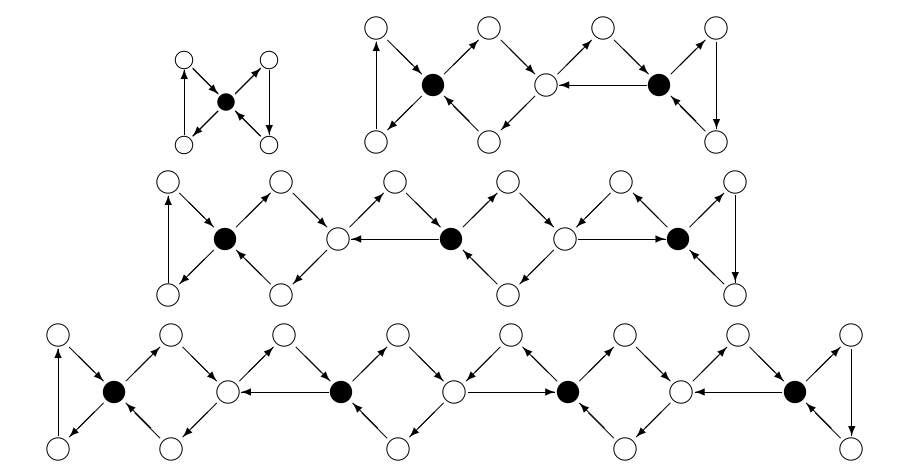
Fig. 1: Examples with large minimum oriented diameter in dependence of the domination number γ ( G ) – the bad examples.